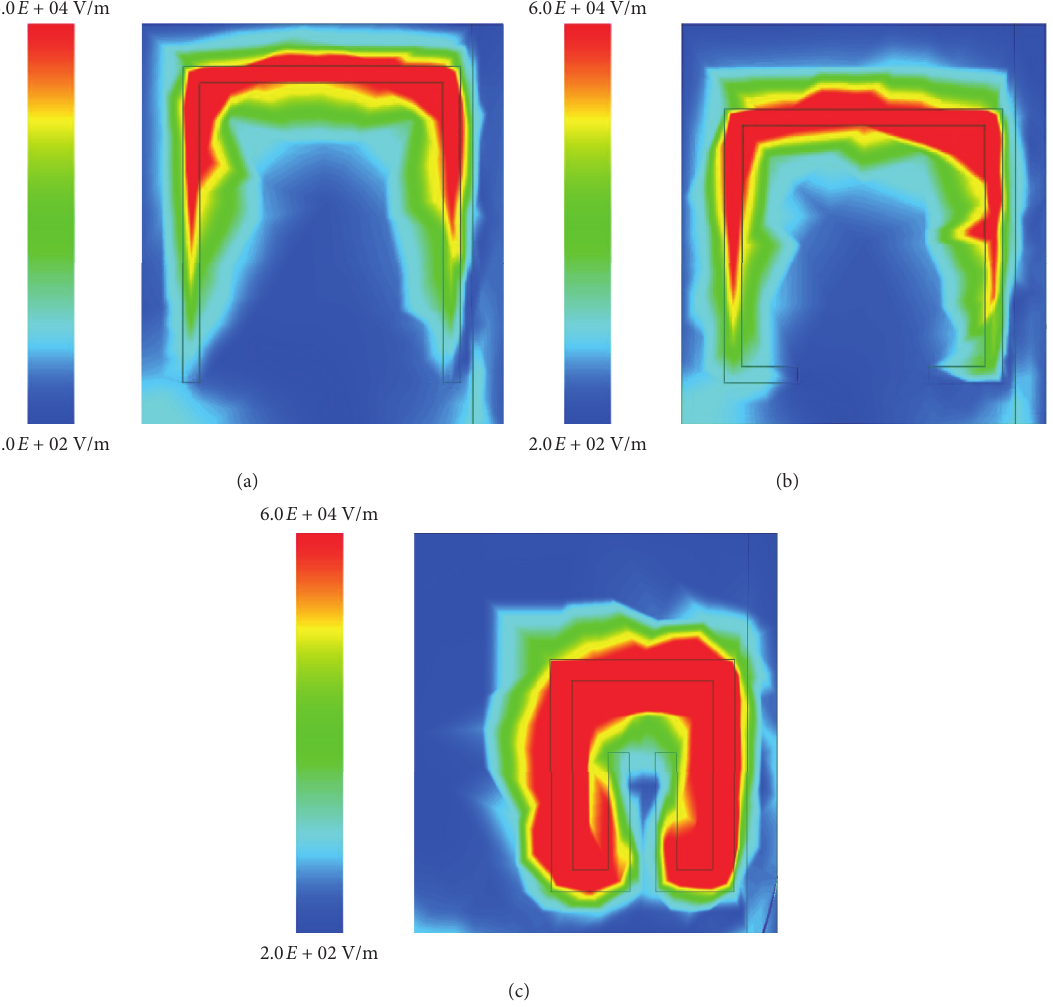
Figure 4: E-field distribution of slot line at different structure. (a) The ordinary rectangular slot. (b) The complementary split-ring slot with C-shape. (c) The